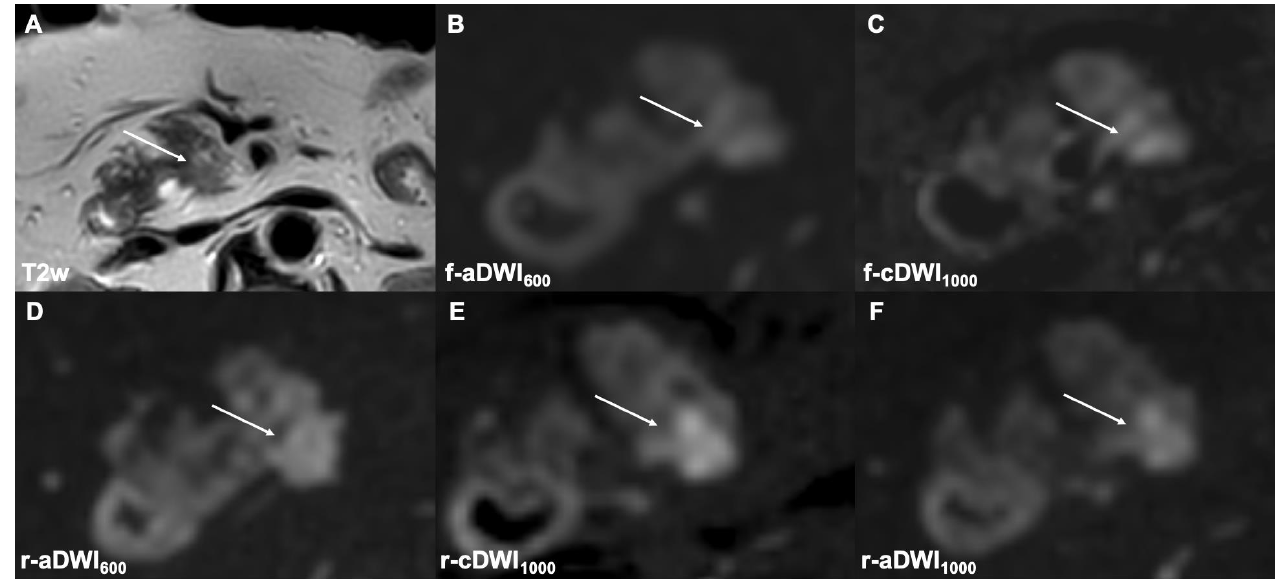
Figure 2. The axial T2w image shows a small tumor in the pancreatic head ( A , white arrow) with an unclear border (type 2) to the adjacent parenchyma in both the f-aDWI600 ( B ) and f-cDWI1000 ( C ) images. Better lesion detection and tumor-to-parenchyma contrast (type 1) are depicted in the r- cDWI1000 ( E ) image compared to the r-aDWI600 ( D ) image and the directly acquired image at b = 1000 s/mm 2 ( F ). The labeling in image ( E ) has been corrected.